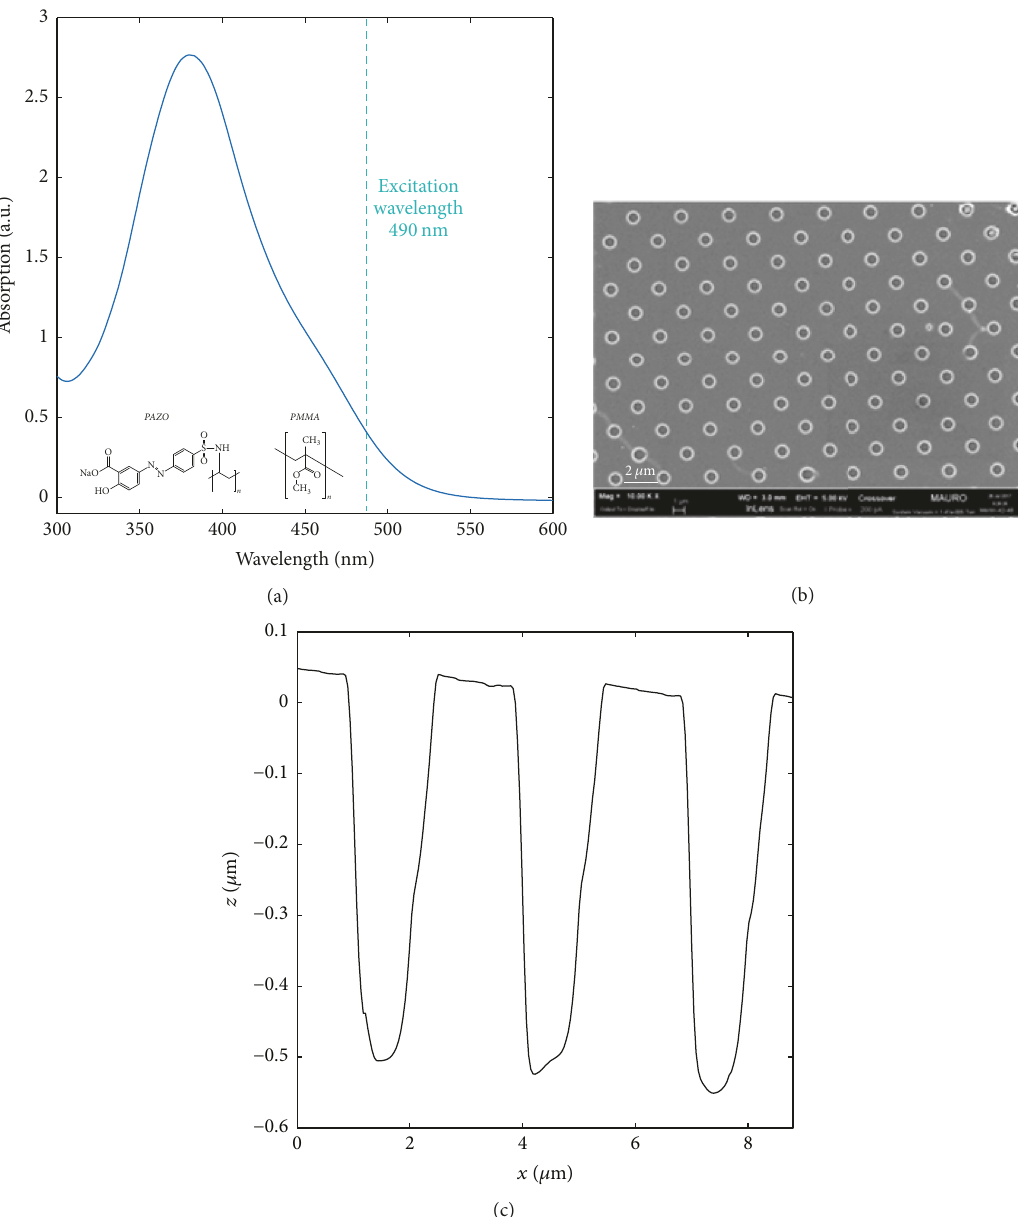
Figure 1: (a) Absorption spectrum of the PAZO-PMMA compound in the UV-Visible range. In the inset, sketch of the chemical structure of the two polymers. (b) SEM image of the array of microwells. (c) AFM profile of the